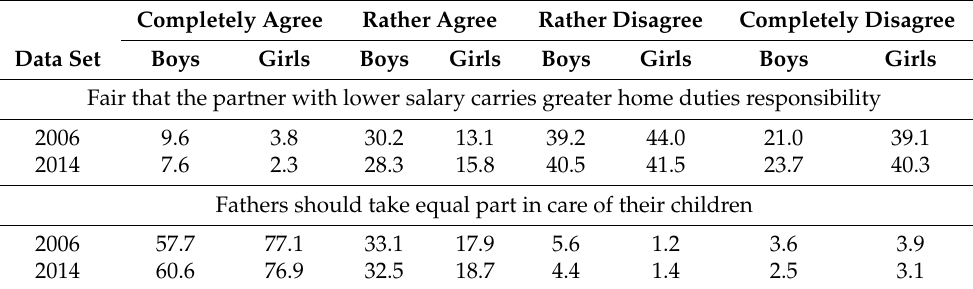
Table 4. Percentage attitude towards home duties responsibilities and care of